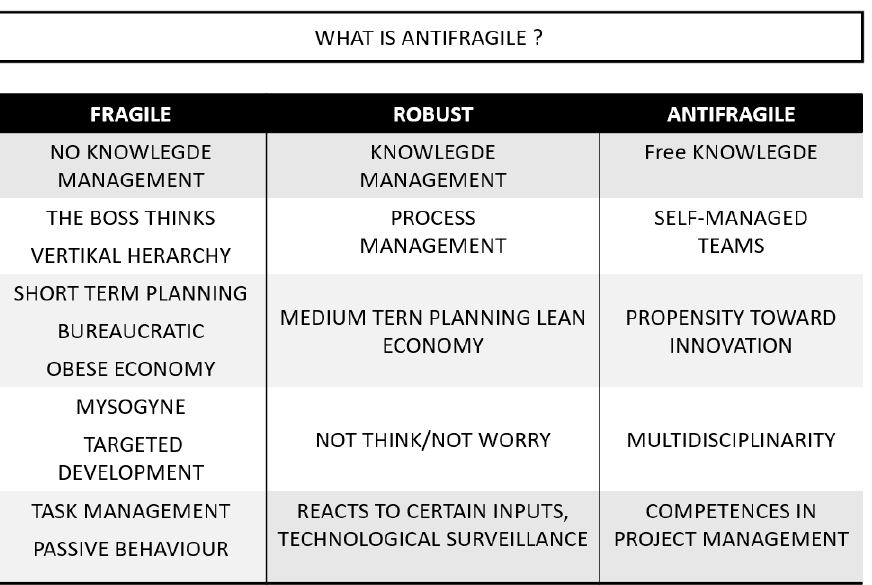
Figure 3. Comparison of behaviours in different organizations.